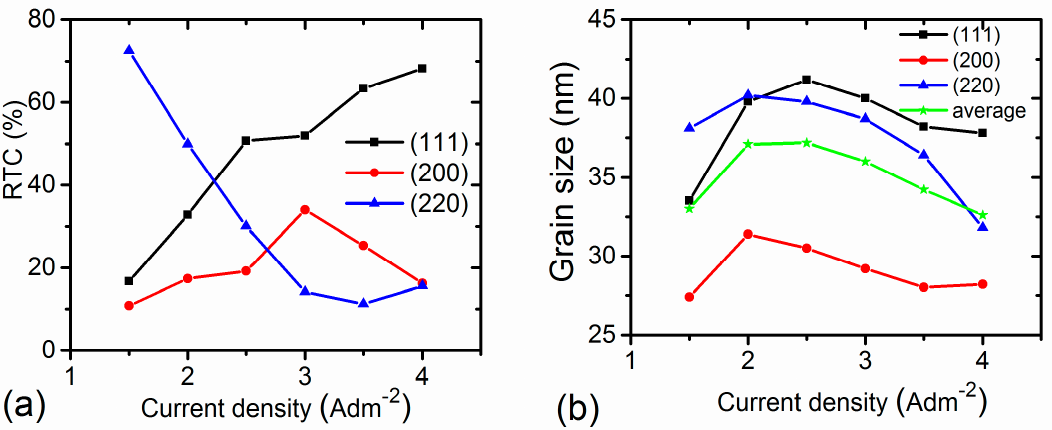
Figure 4. ( a ) Variation of RTC (hkl) for different diffraction peaks with varied current densities; ( b ) effect of current density on grain size from different diffraction peaks and average grain size.